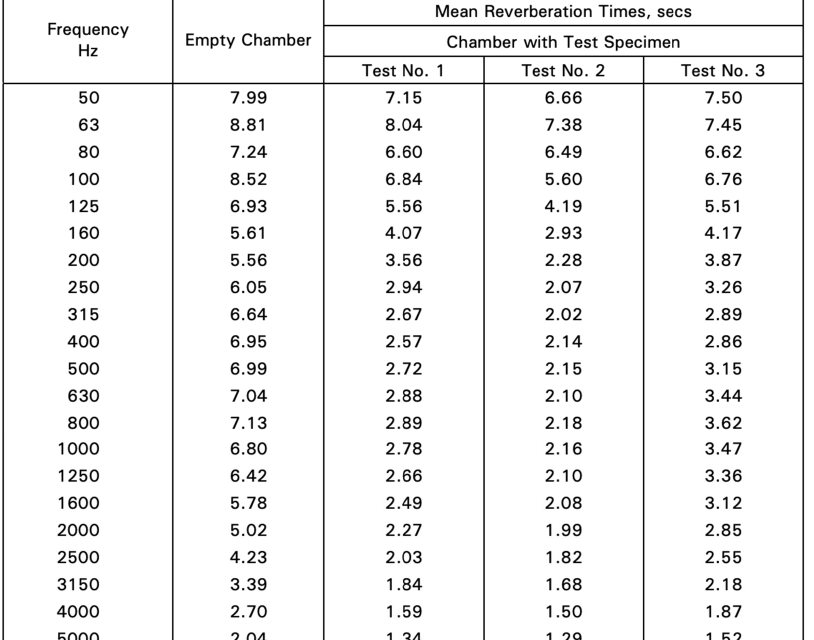
Table 2. The comparative characteristics of Biotecture’s green wall systems. Parameter